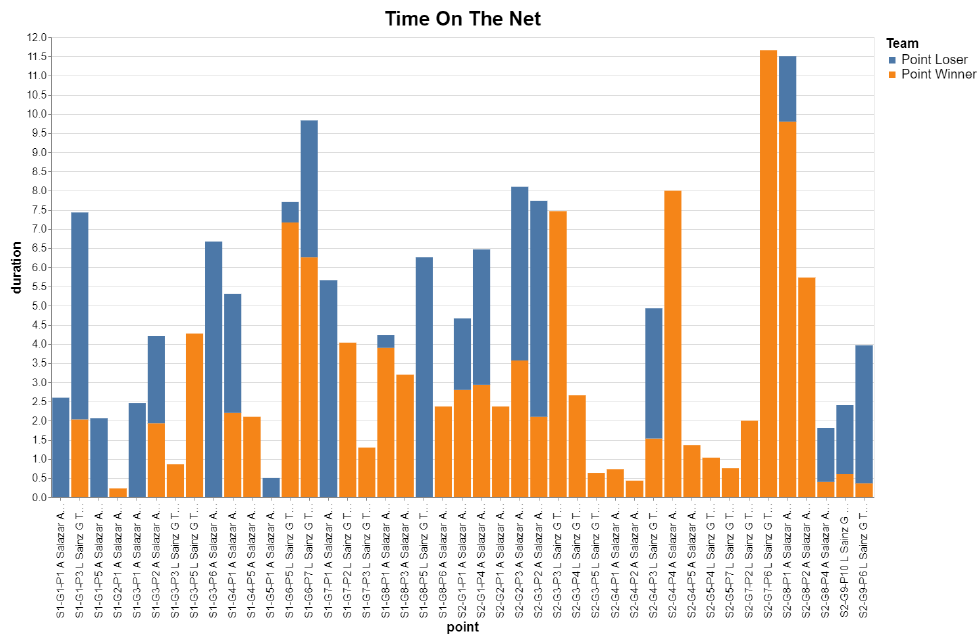
Figure 17. For each point, the bar chart shows the time (s) spent in the net zone (less than 4 m from the net) by the players of the point winning team and the point losing team. Point labels include the game-set-point id of the point, and the team that won that point.